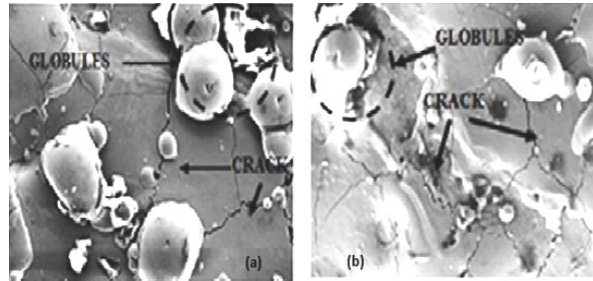
Figure 17. (a, b) SEM images of the work piece surface.